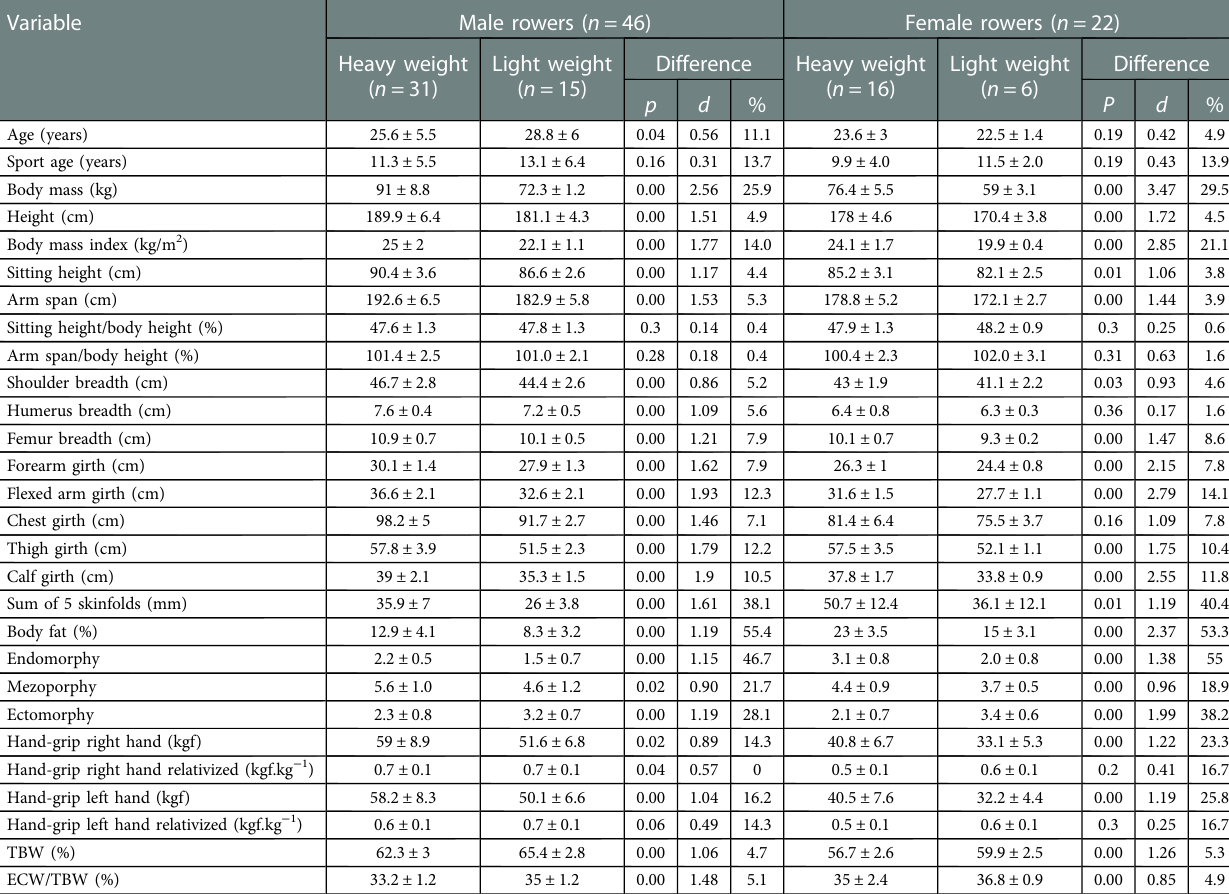
TABLE 1 Morphology, intersex and inter category differences of the 2022 world championship